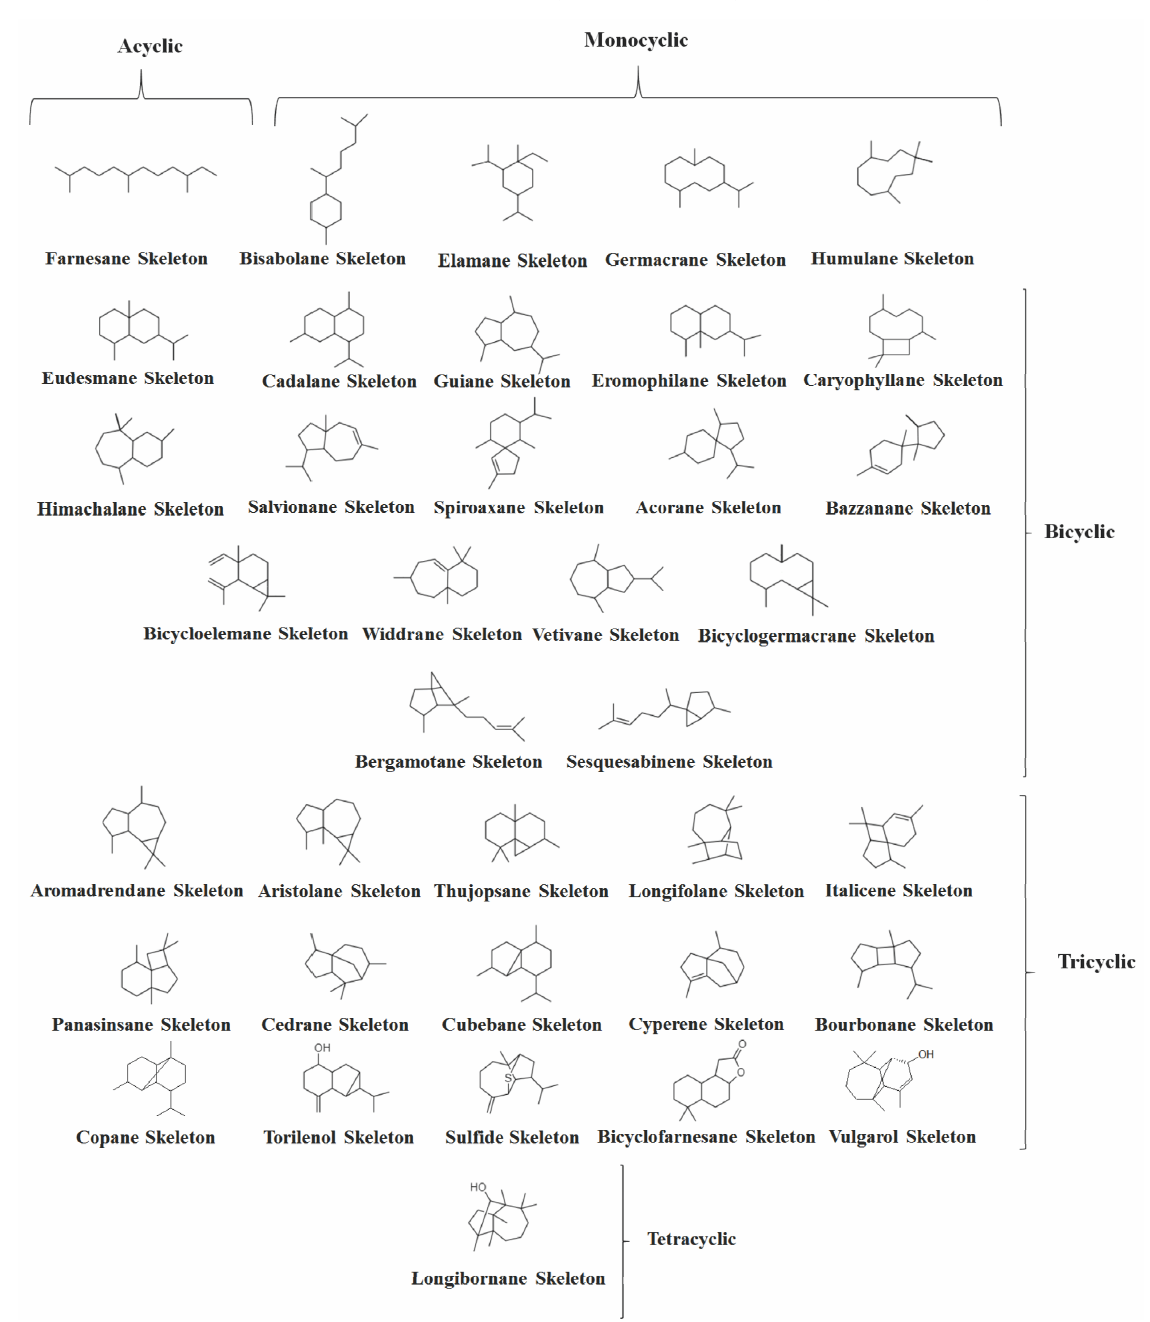
Figure 2. Structures of parent carbon skeletons of all sesquiterpenes identified in Vitex .